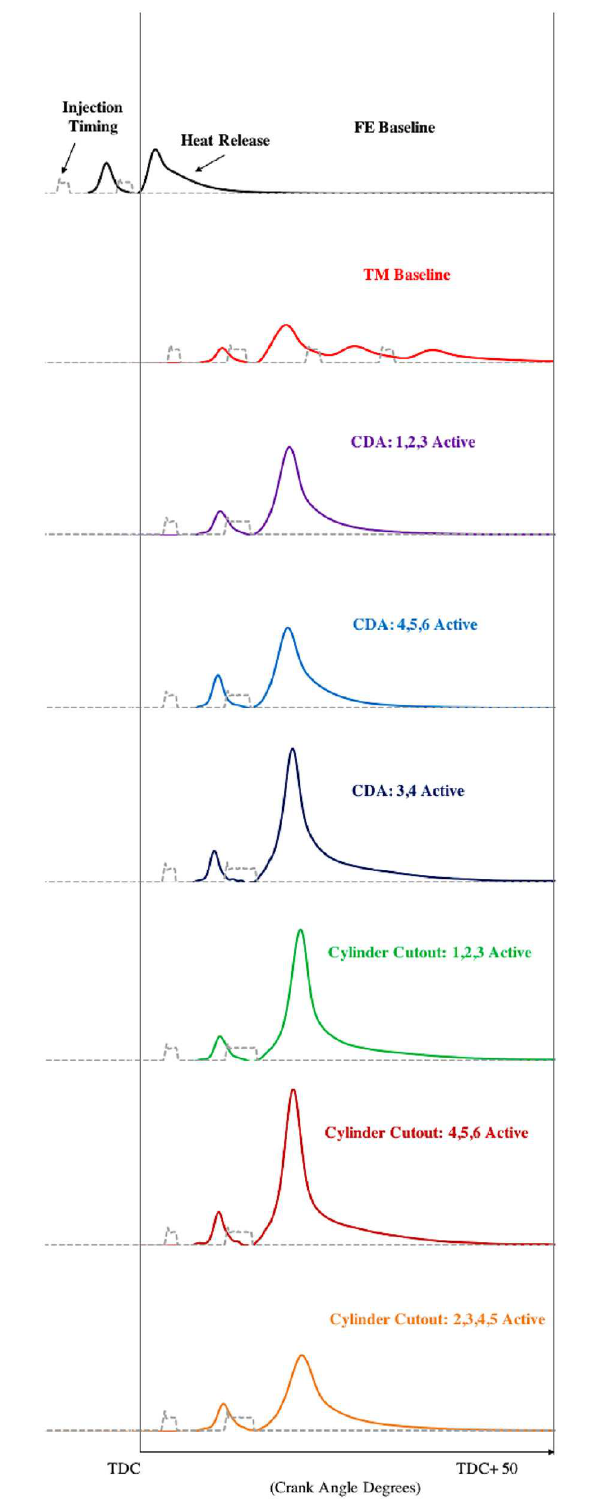
FIGURE 5 | Heat release rates and injection timings for each strategy on a crank angle degree basis. The heat release rates are an average of the active (firing) cylinders in each